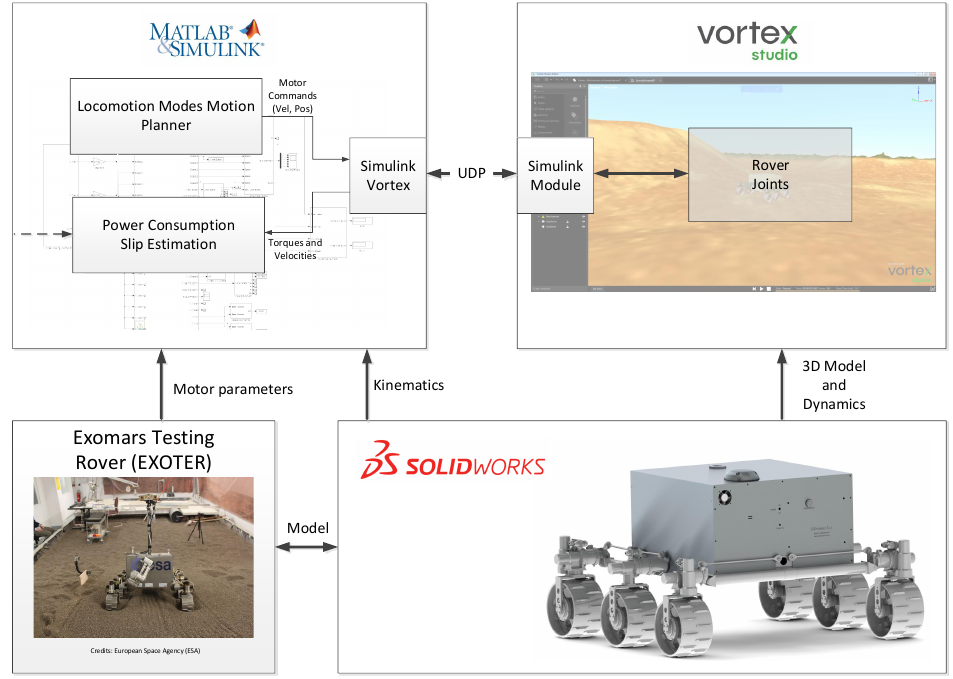
Figure 5. Simulation environment. It shows interactions between the used software. The 3D model of the ExoTeR rover is obtained from SolidWorks and included within Vortex Studio. Matlab & Simulink is used to perform the locomotion modes motion planner, retrieve power consumption and estimate the slip ratio during wheel